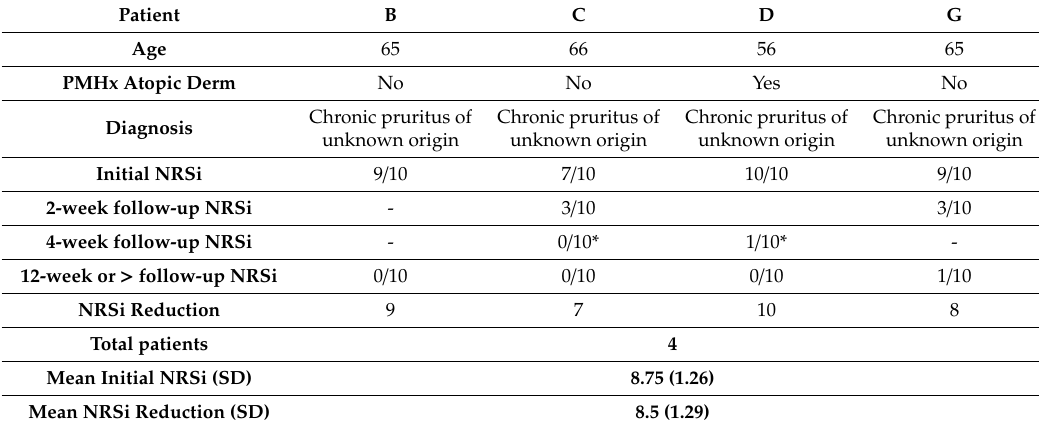
Table 4. Chronic pruritus of unknown